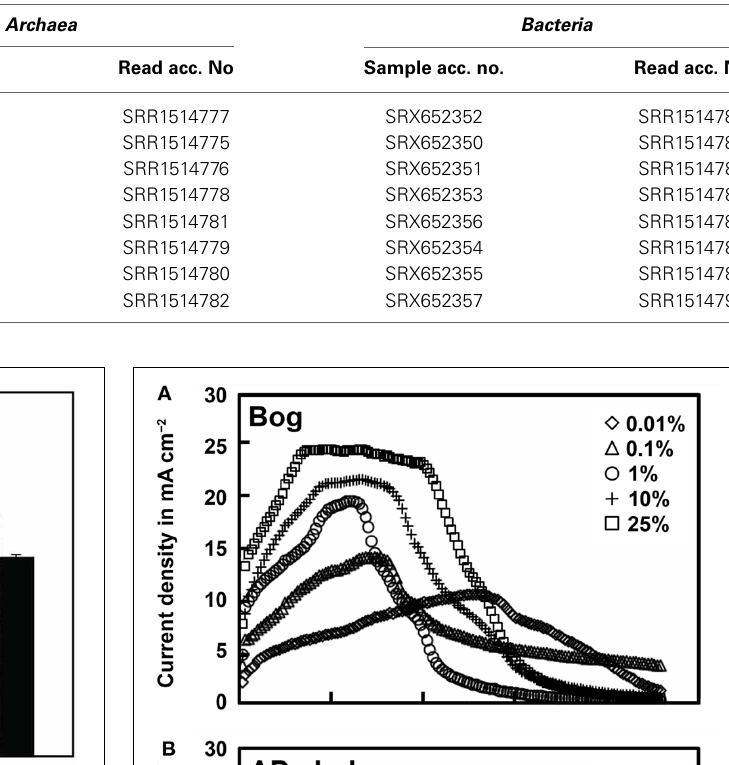
Table 1 | List of samples with corresponding accession numbers for the Sequence Read Archive http://ncbi . nlm . nih . gov/sra.